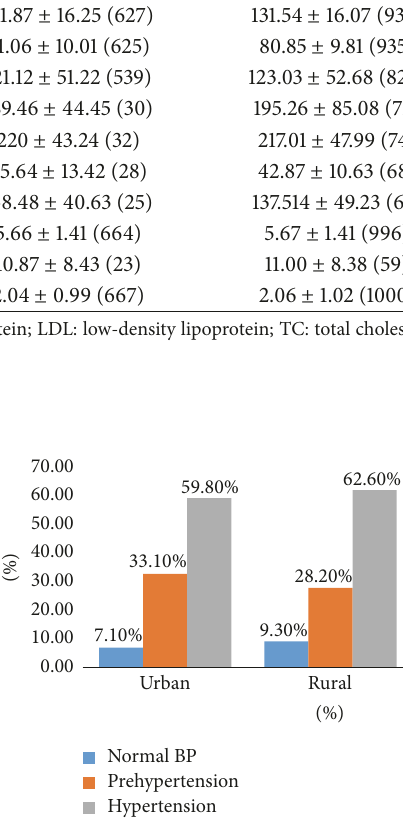
Figure 1: Prevalence of normal BP, prehypertension, and hyperten-